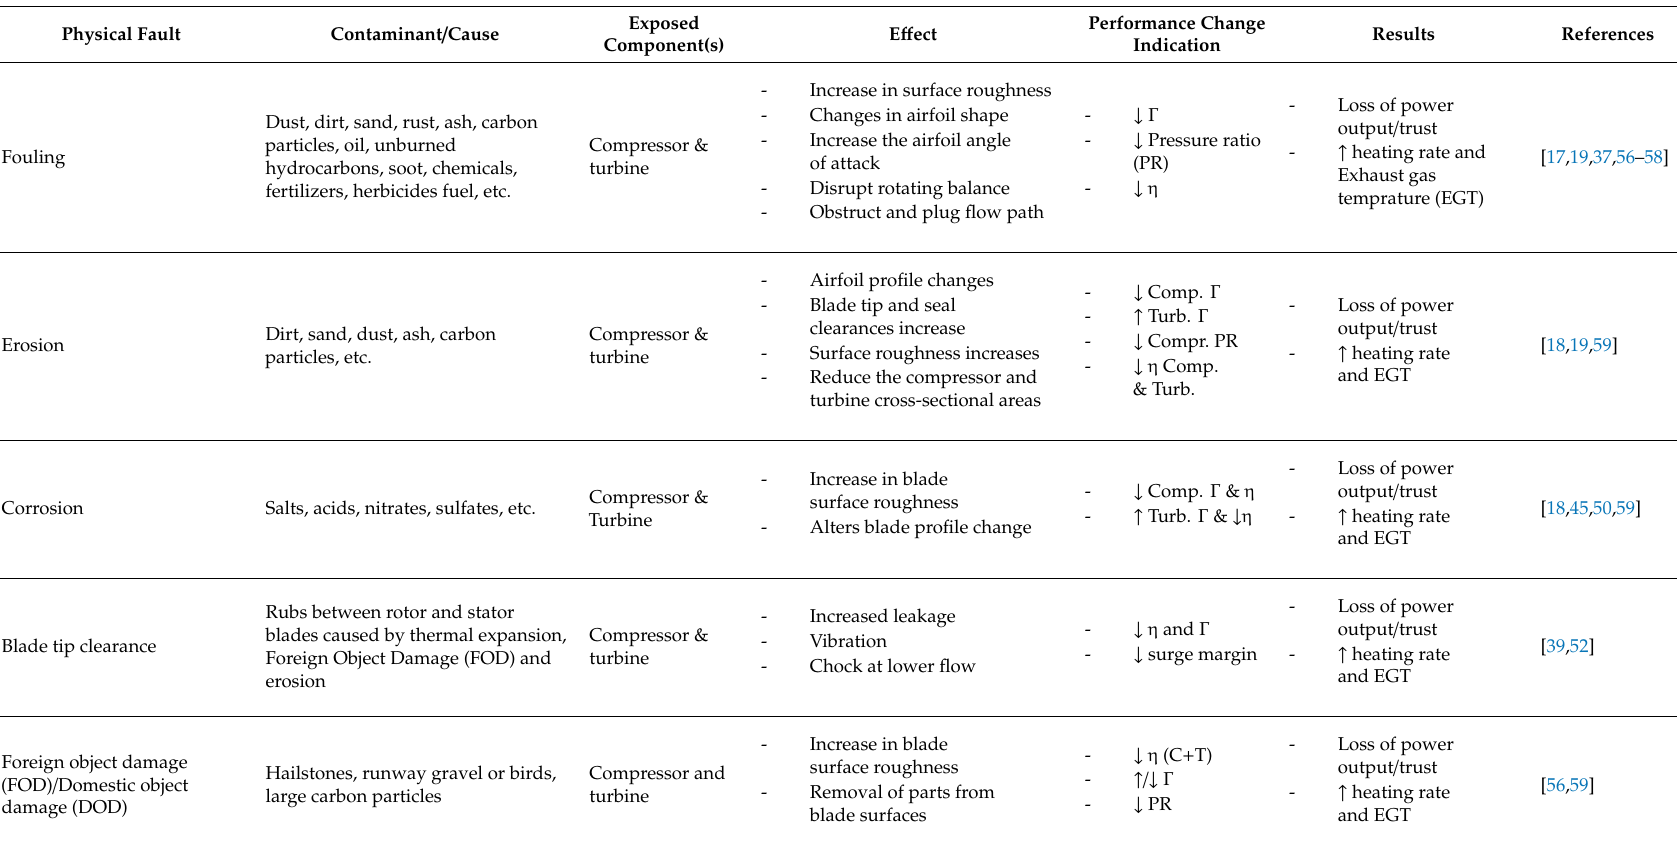
Table 2. Summary of GT degradation causes, e ff ects, and component performance change